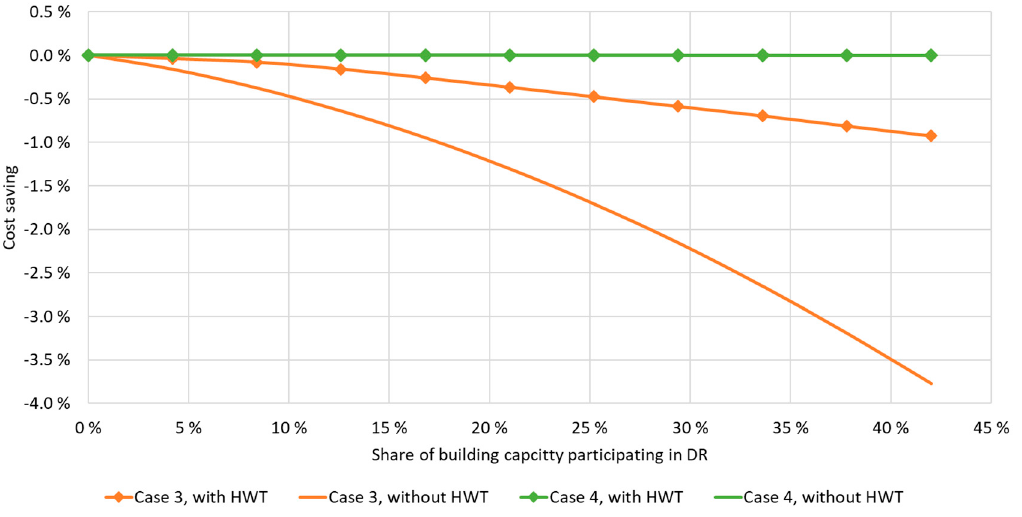
Figure 5. Impact of DR cases 3 and 4 on the heat production costs compared to the reference case. In Case 3, the DR measures increase costs.